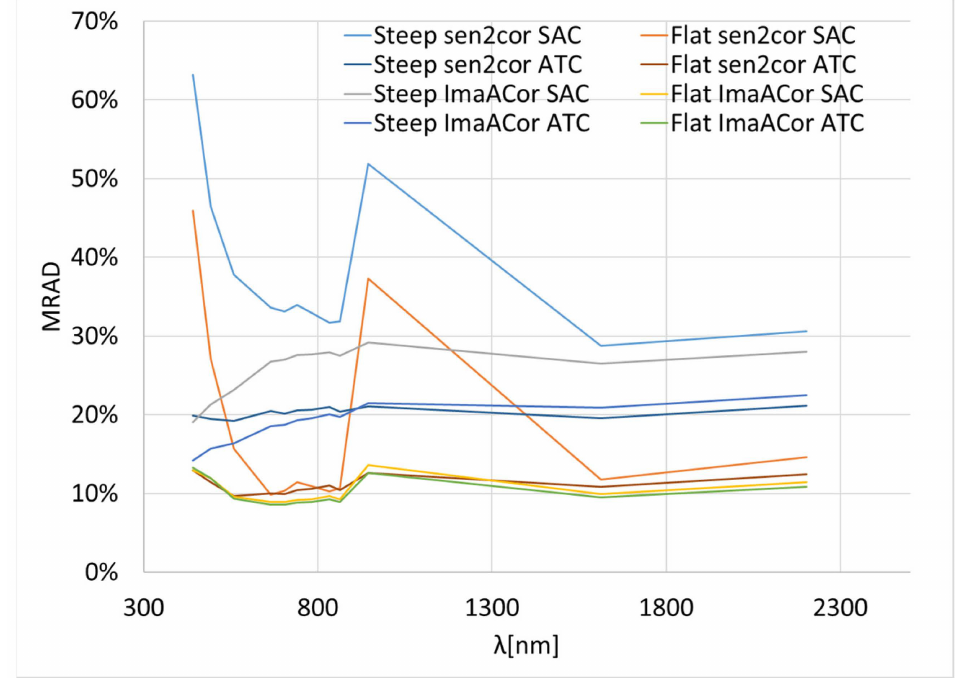
Figure 8. MRAD plots, as a function of wavelength, of sen2cor and ImaACor SAC and ATC re- flectances, obtained from L1 sentinel 2 data, for flat and steep